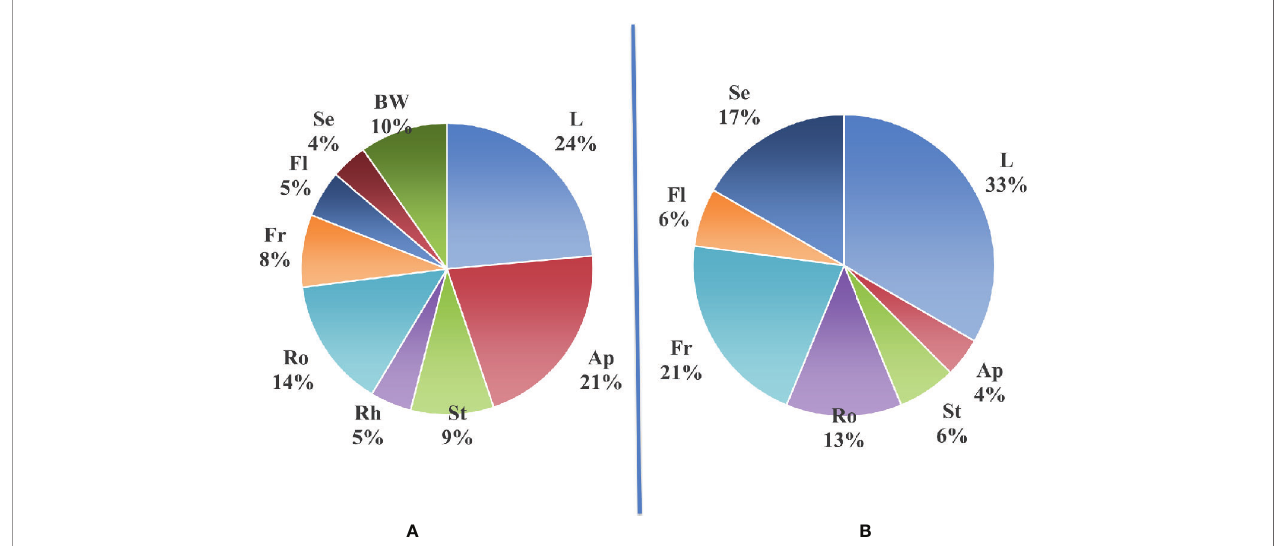
FIGURE 3 | Distribution of newly reported compounds according to the part of plants from which they were extracted. (A) : Proportion of new compounds reported in different parts from the plant (from our survey); (B) : Proportion of active compounds in different plant parts reported in Ross work (Ross, 1999; Ross, 2001). Ap, aerial parts; BW, bark and wood; Fl, fl owers; L, leaves; Fr, fruit; Rh, rhizome; Ro, roots; Se, seeds; St,